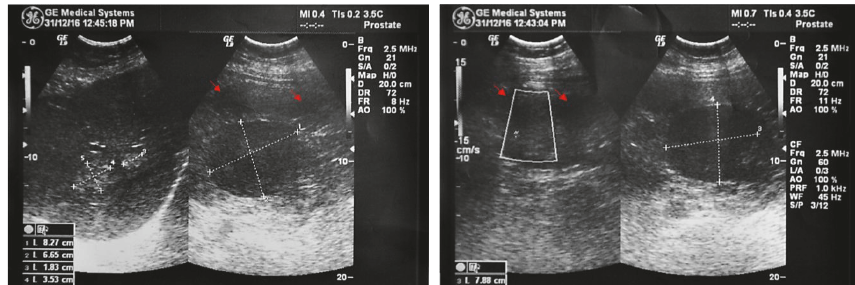
Figure 1: The right kidney masses probably are liver hematomas (red arrows).